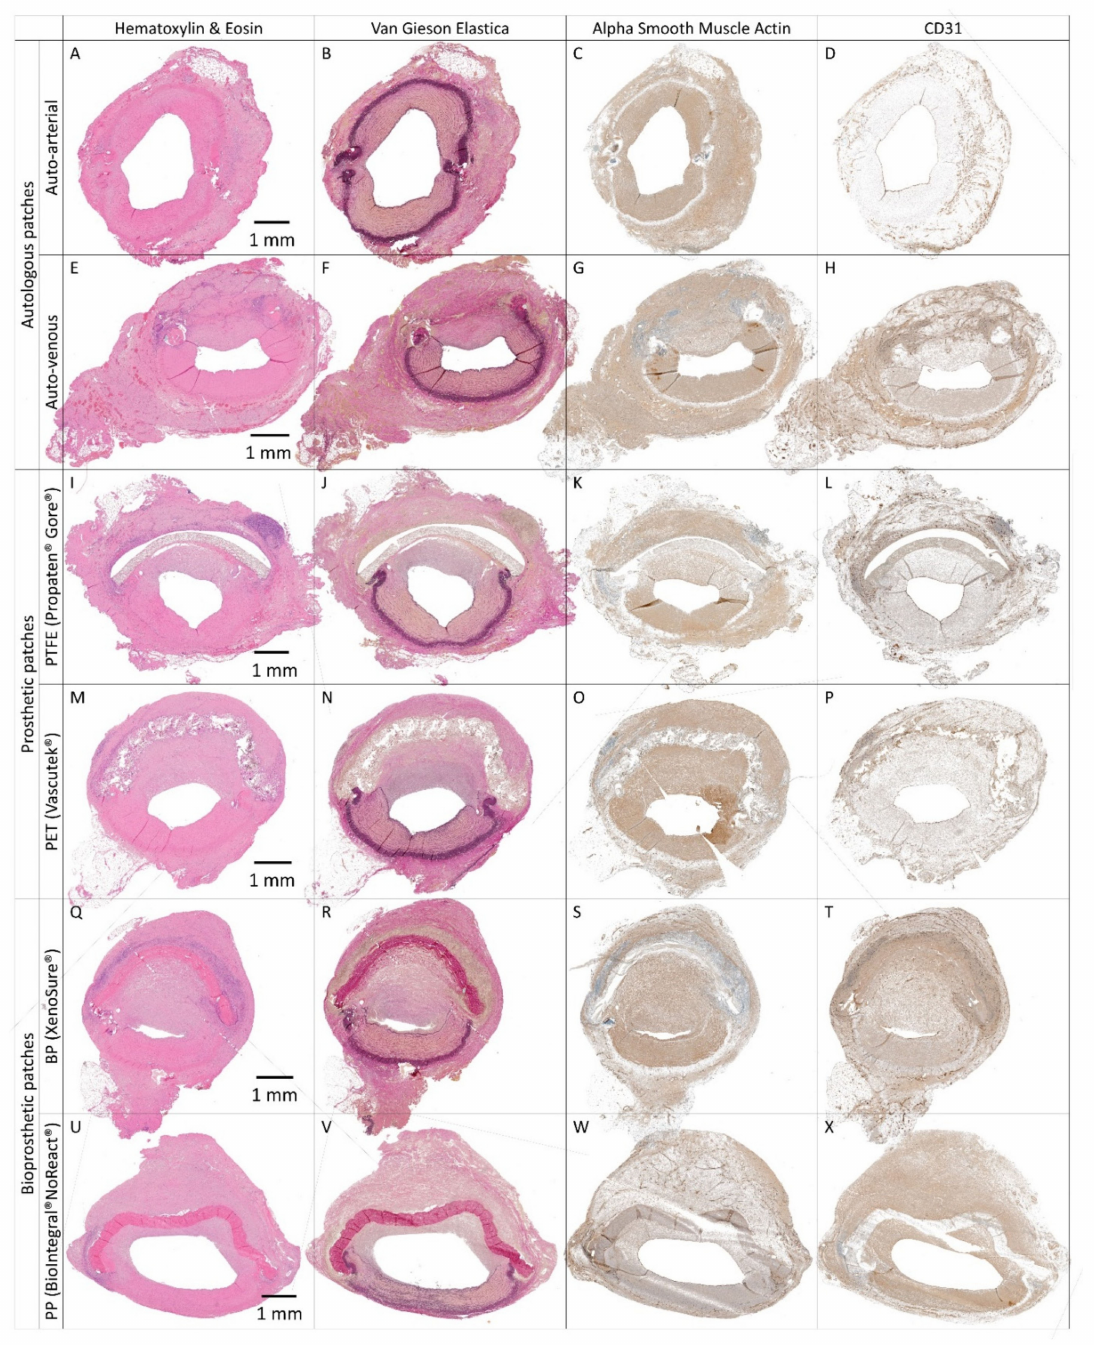
Figure 7. Histology and immunohistochemistry of control vascular patches in porcine carotid arteries 1 month post-implantation. We implanted two types of autologous patches: ( A – D ) arterial autografts and ( E – H ) venous autografts; two kinds of prosthetic patches: ( I – L ) expanded polytetrafluoroethylene (ePTFE, Propaten ® Gore ® ) and ( M – P ) polyethylene terephthalate (PET, Vascutek ® ); and two types of bioprosthetic patches: ( Q – T ) bovine pericardium (BP) chemically stabilized with glutaraldehyde (XenoSure ® ) and ( U – X ) detoxified porcine pericardium (PP, BioIntegral ® NoReact ® ). Representative cross-sections of the midgraft regions are shown. Implanted patches comprise the upper half of the vessel, magnification 20 × . The apparent lumen loss in XenoSure ® ( Q – T ) was probably due to spasms during